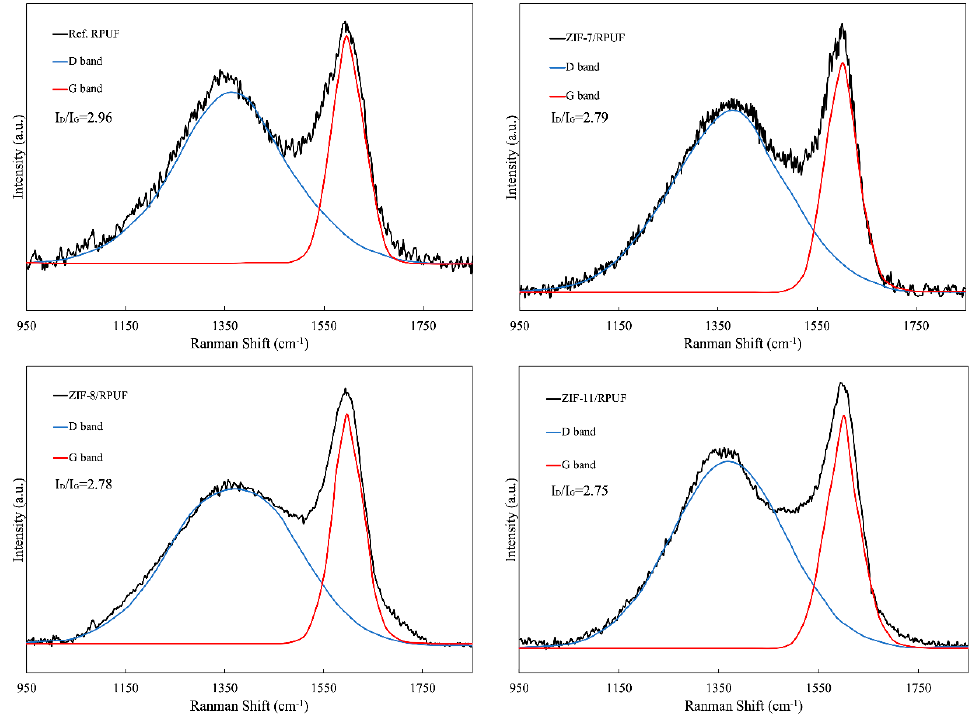
/ RPUF, ZIF-8 / RPUF and ZIF-11 /